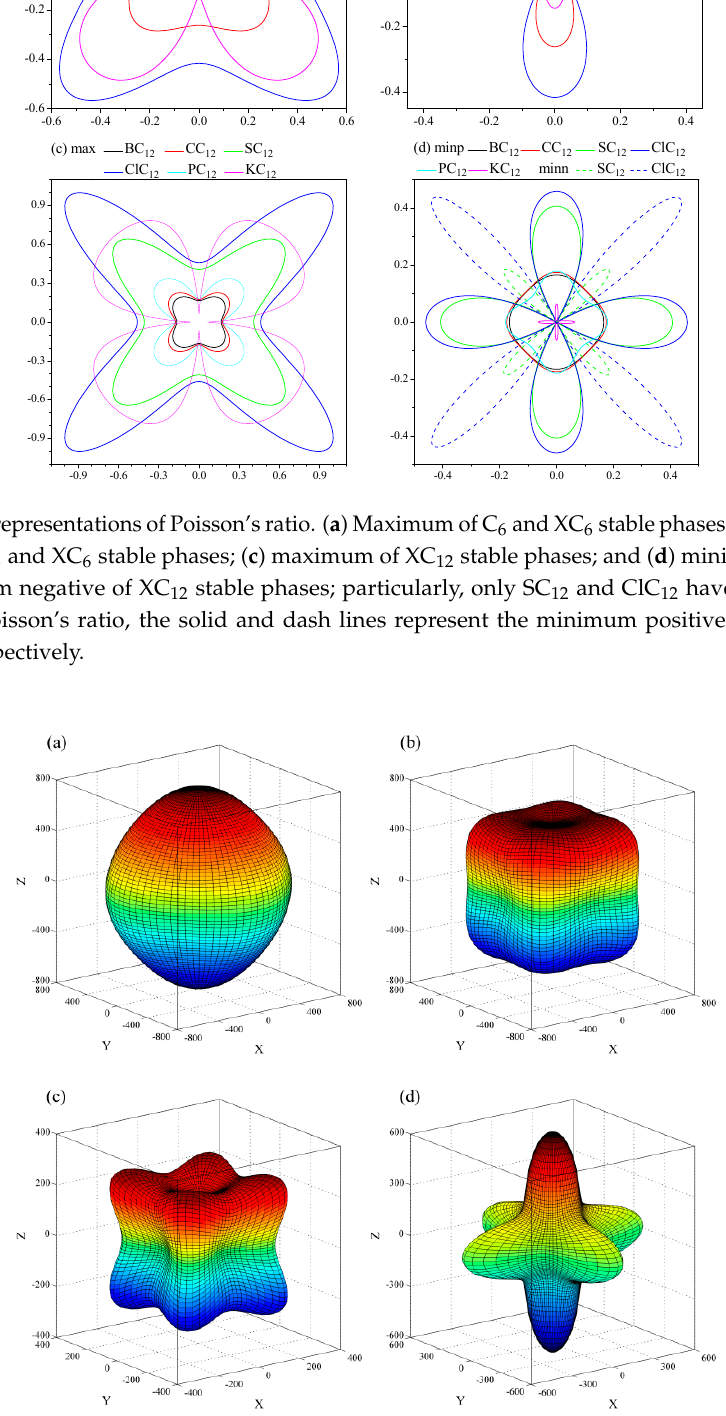
Figure 6. Directional dependence of the Young’s modulus of C 6 ( a ); HC 6 ( b ); NC 6 ( c ); and SC 6 ( d ).